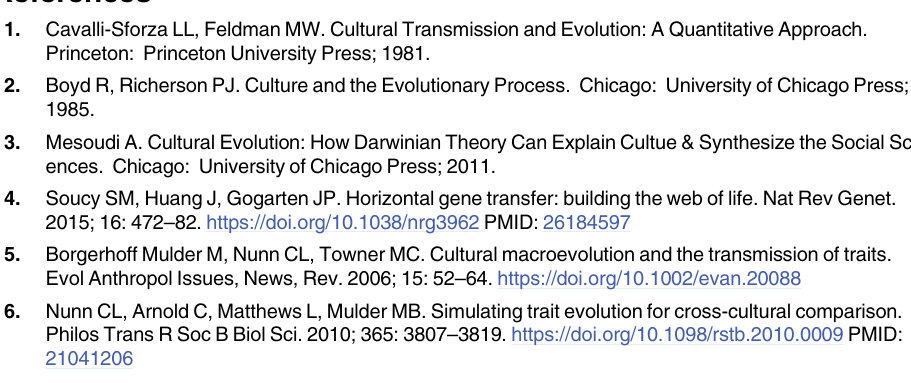
S1 Fig. Neighbor-Net graphs. (a) Neighbor-Net graph based on the linguistic distances among the ten islands ( δ = 0.202). (b) Neighbor-Net graph based on the genetic distances among the five islands ( δ = 0.193). Colors indicate the regions. S2 Fig. Comparison of F values between social contexts. Each panel shows the frequency ST distribution of the difference in the F values for the five regions (Fig 1) between different ST social contexts calculated from 1,000 bootstrap samples. The observed differences in F indicated by the vertical dashed lines. F of "work" songs was significantly larger than that of ST (a) "child" songs ( p = 0.023), (b) "ritual" songs ( p = 0.023), and (c) "amusement" songs ( p =